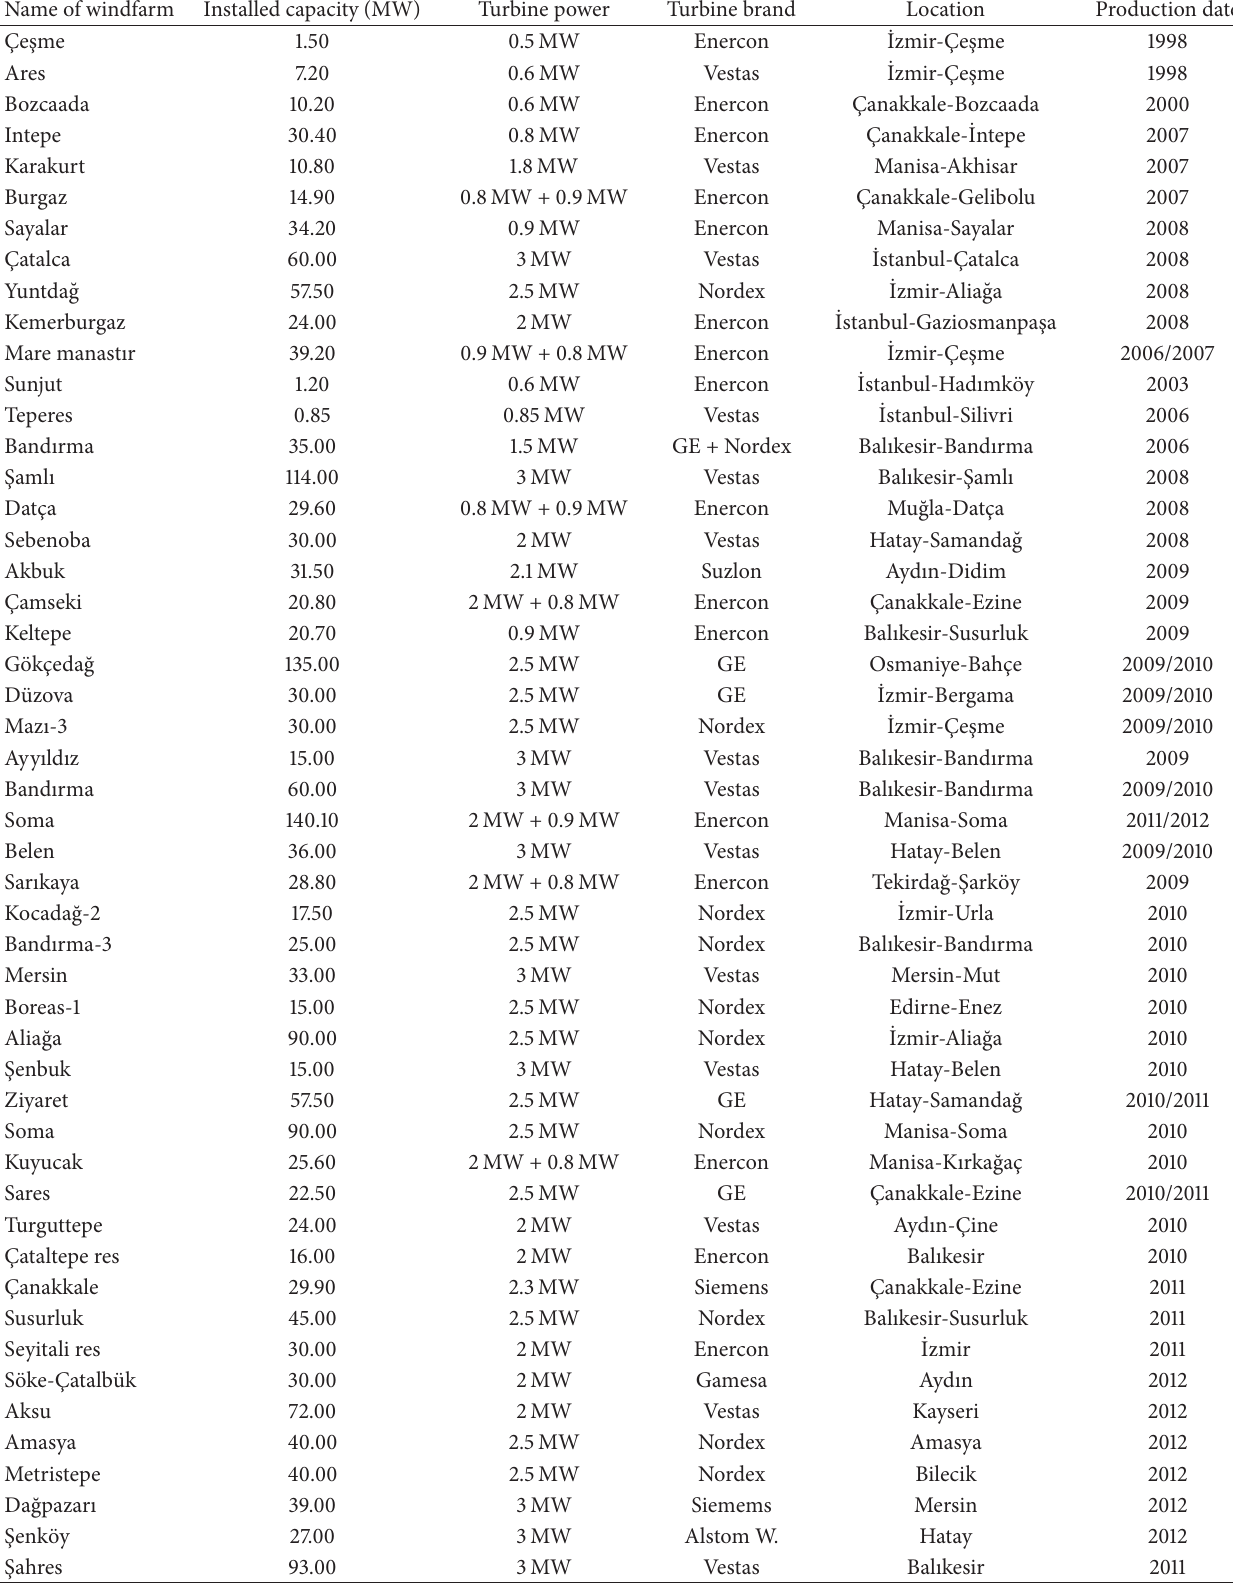
Table 3: Wind power plants under operation in Turkey (July